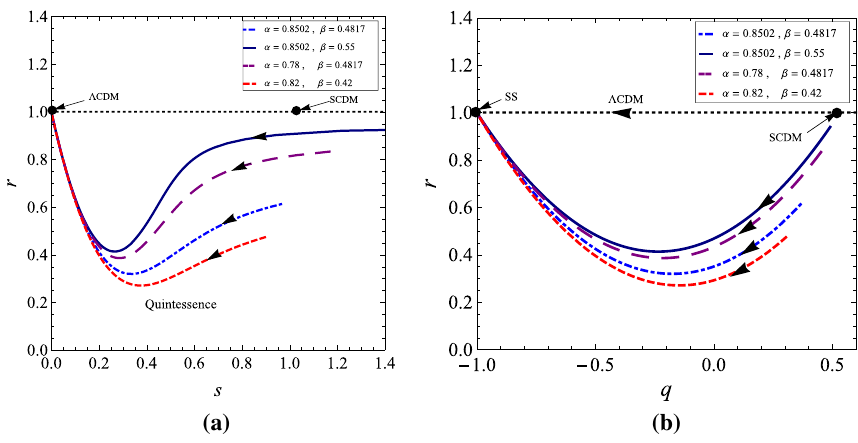
Fig. 4 a The r − s trajectories are plotted in r − s plane for different values of α and β with ω = − 0 . 5 and ζ = 0 . 02. The d 0 arrows represent the directions of the evolutions of statefinder diagnostic pair with time. b The r − q trajectories are plotted in r − q plane for different values of α and β with ω d = − 0 . 5 and ζ = 0 . 02. The arrows represent 0 the directions of the time evolution pair { r , q } with